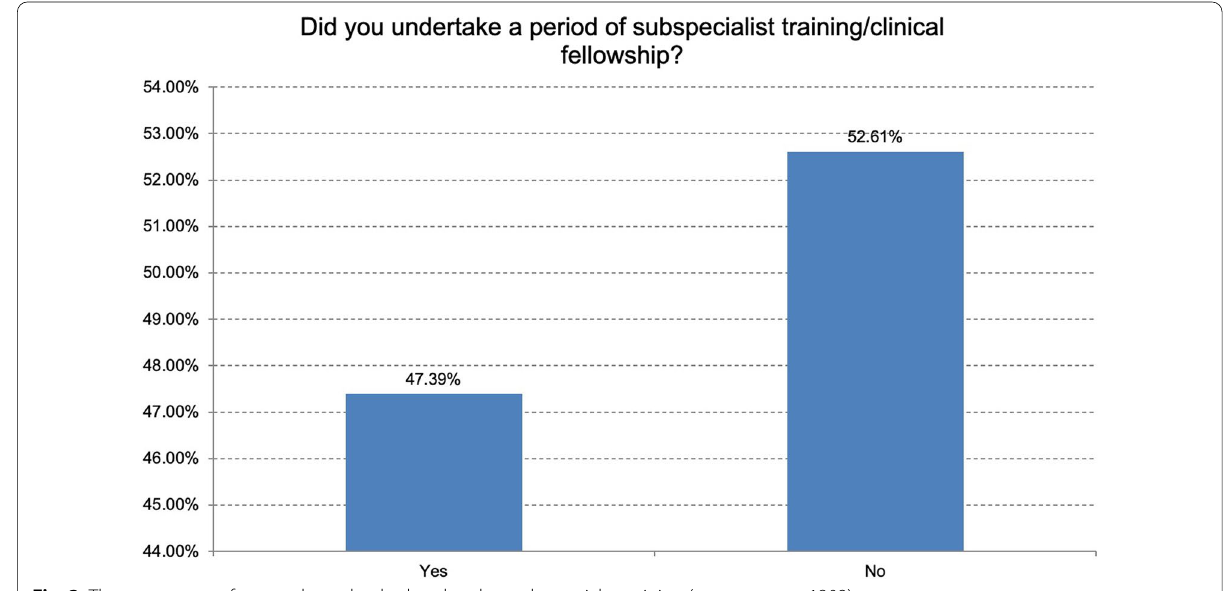
Fig. 3 The percentage of respondents that had undertaken sub-specialty training (responses n